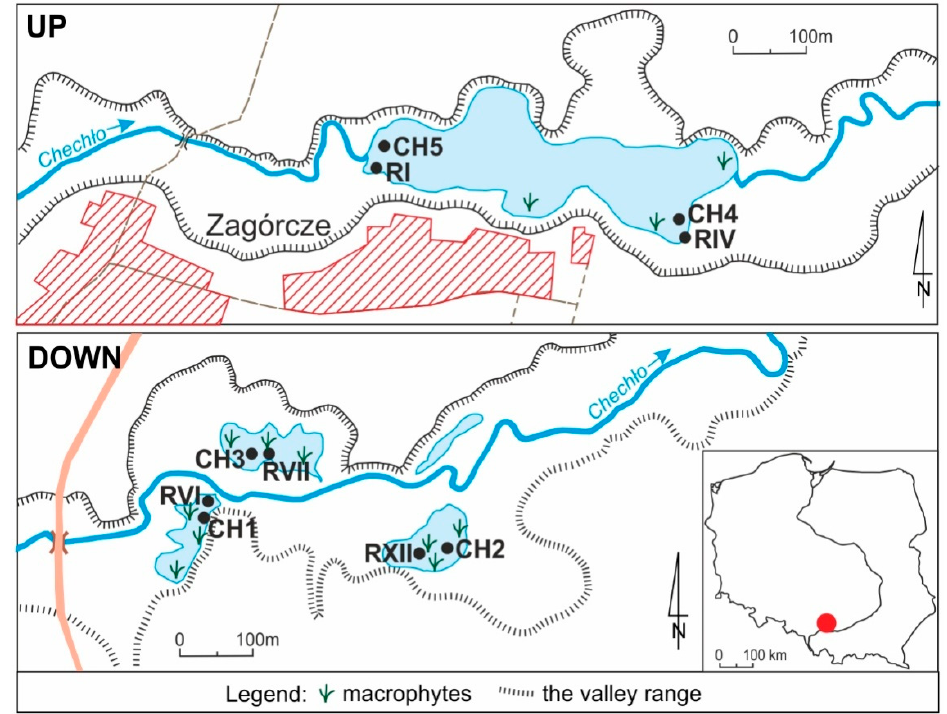
Figure 1. Sampling area-UP: Subsidence pond formed after the mine closure: water and plankton samples—CH4, CH5, and sediment cores: RI, RIV; DOWN: Subsidence ponds formed during peak exploitation: water and plankton samples–CH1, CH2, CH3 and sediment cores: RVI, RVII, RXII.